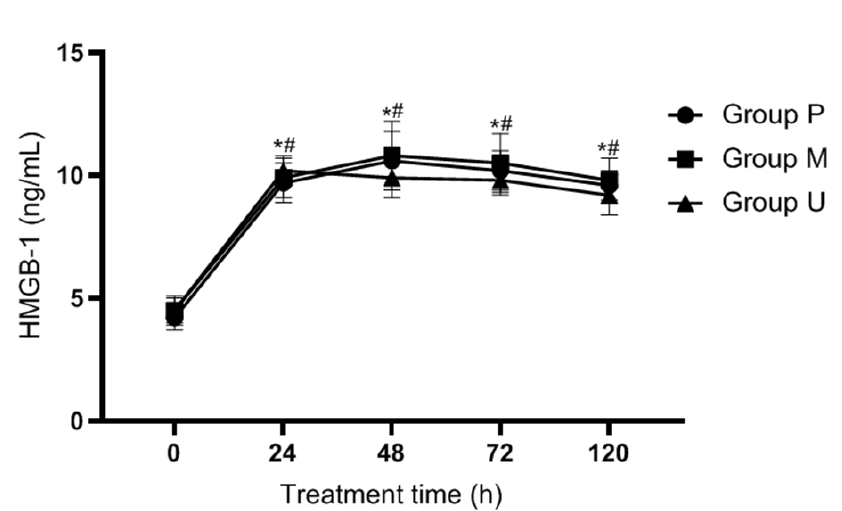
FIGURE 4 - Comparison of HMGB-1 levels among the three groups at different treatment times. *P < 0.05 compared with group P at the same time point; #P < 0.05 compared with group M at the same time